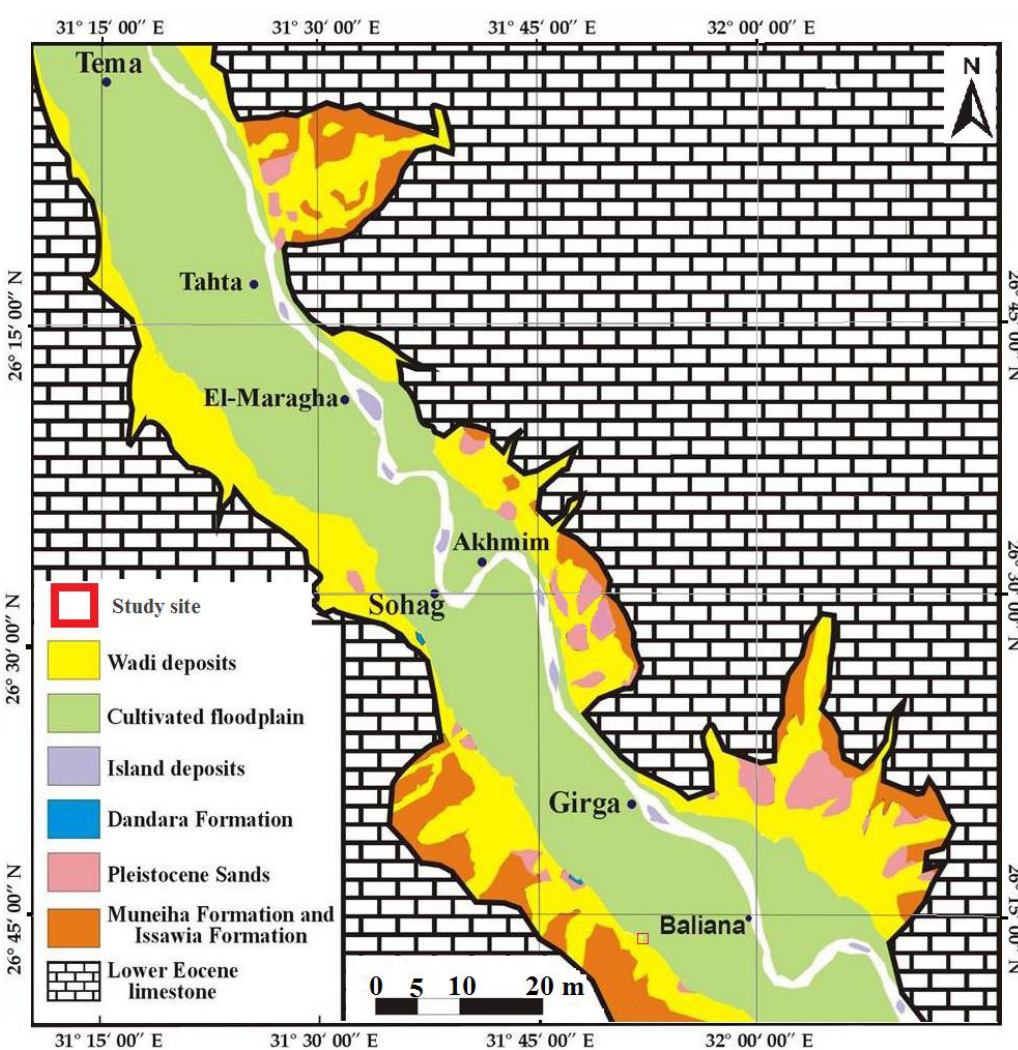
Figure 2. Simplified geological map of Sohag Governorate [62] .